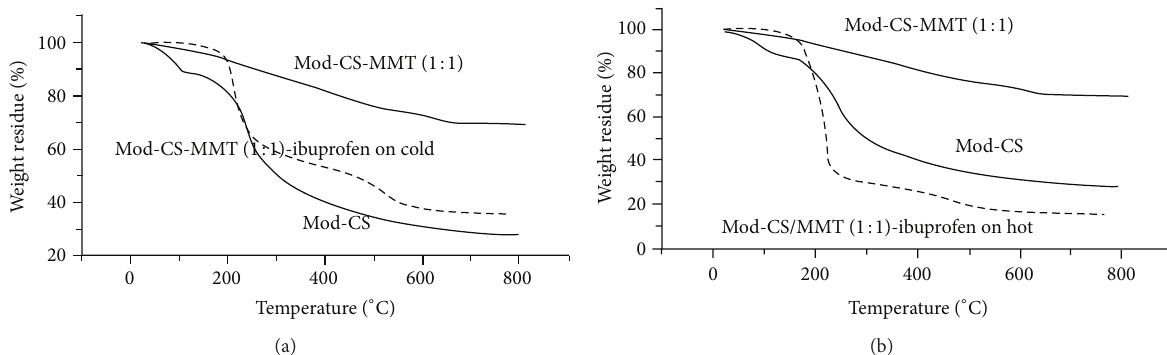
Figure 4: TGA of mod-CS, mod-CS/MMT (1:1), and mod-CS/MMT—ibuprofen prepared by solvent method (a) on cold and (b) on hot.